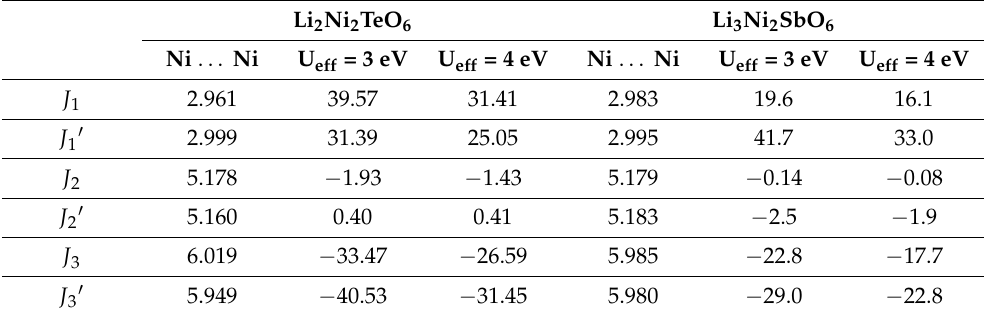
Table 5. Experimental Ni . . . Ni distances (in Å) and calculated spin exchanges (in K), obtained from DFT + U computations, of Li 2 Ni 2 TeO 6 and Li 3 Ni 2 SbO 6 .